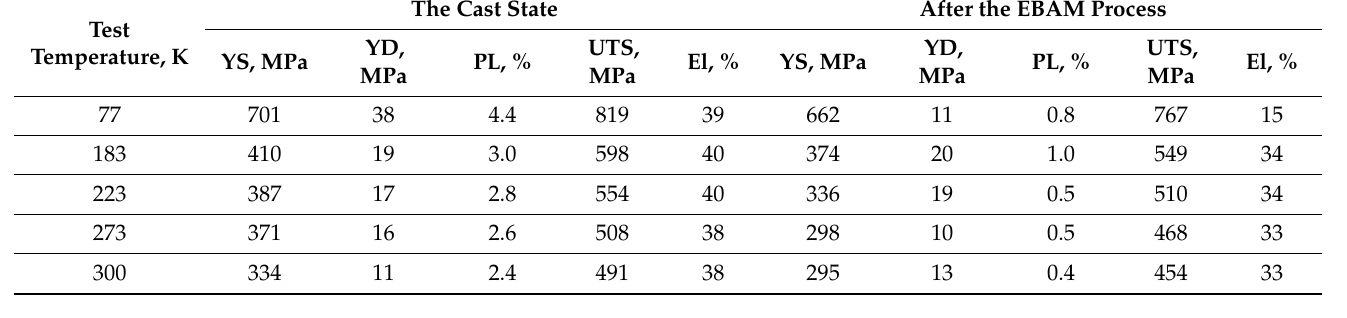
Table 1. Mechanical properties (yield strength—YS, yield drop value—YD, length of the yield plateau—PL, ultimate tensile strength—UTS, relative elongation—El) of the low-carbon steel in the cast state and after the EBAM process.